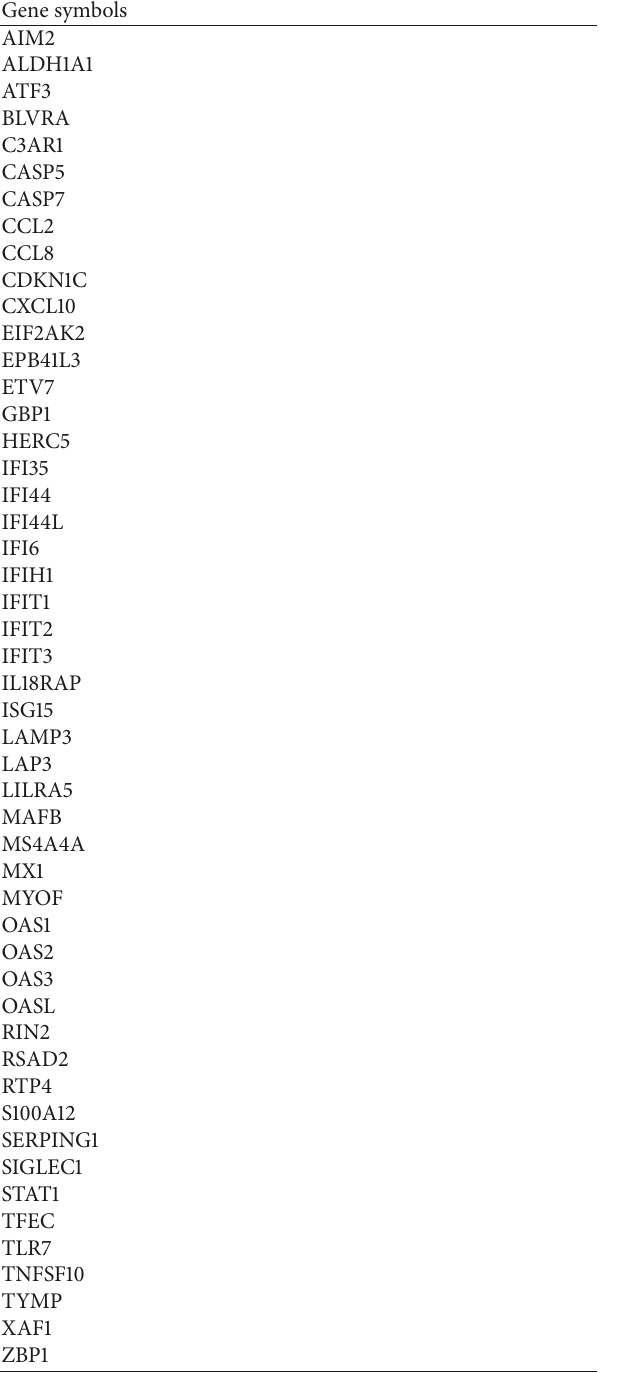
Table 4: Genes selected by the Sparse Disease Severity Score Learning method, listed in alphabetical